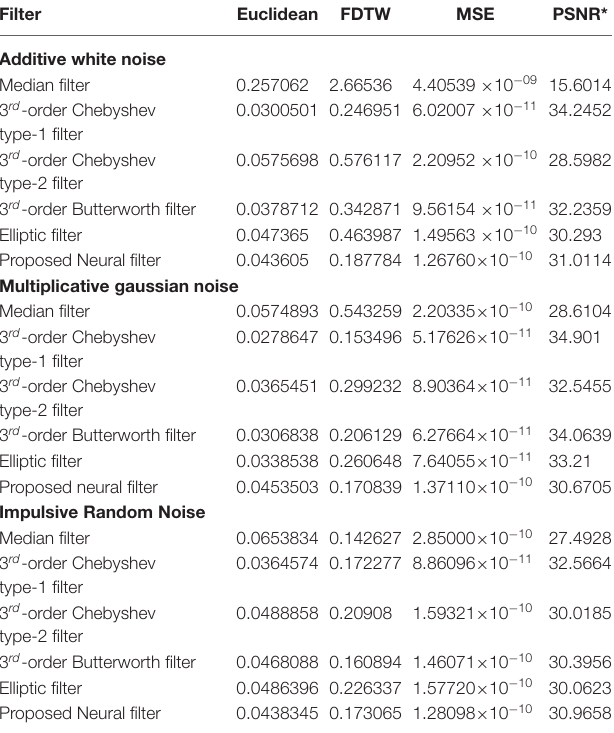
TABLE 1 | Comparison between filter performance with Additive White Noise, Multiplicative Gaussian Noise, and Impulsive Random